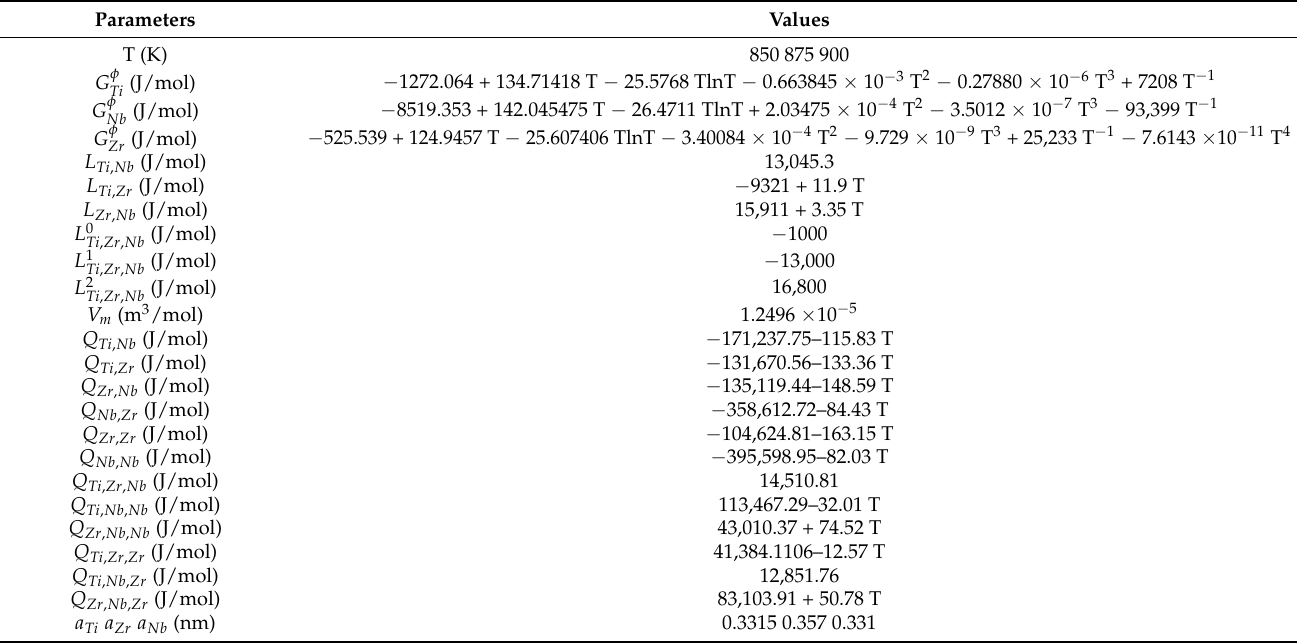
Table 1. The parameters used in simulation of the spinodal decomposition in Zr-Nb-Ti alloys